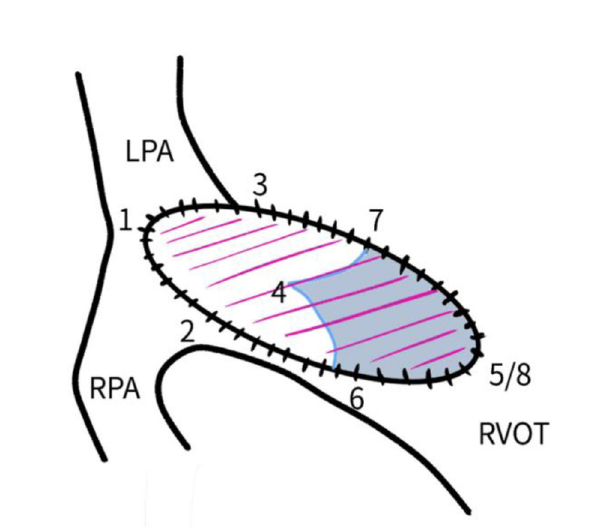
Fig. 1E – At the level of the pulmonary annulus (points 6 and 7), the sutures were tied to the distal sutures used to fix the pericardial patch to MPA to complete the repair. LPA=left pulmonary artery; MPA=main pulmonary artery; RPA=right pulmonary artery; RVOT=right ventricular outflow tract